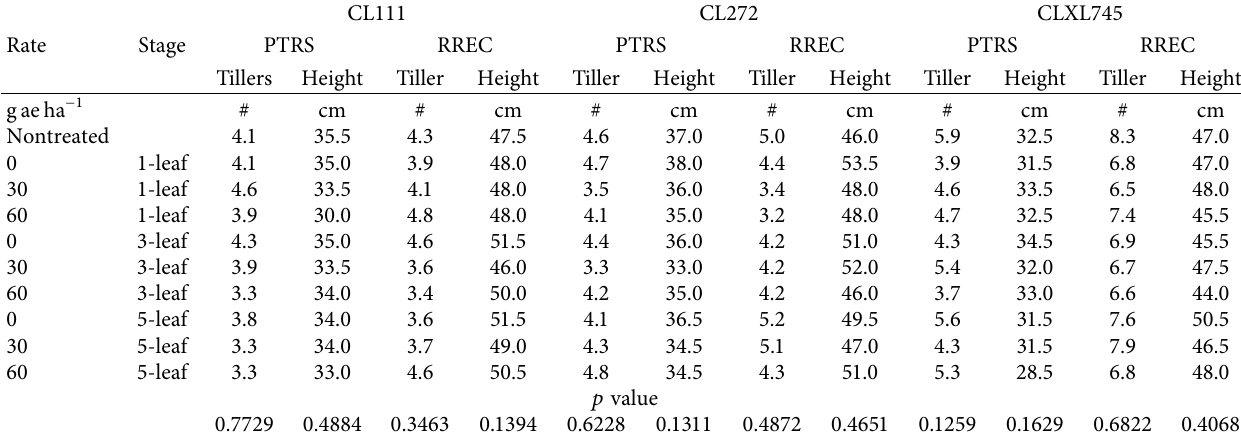
Table 2: Number of tillers and plant height for CL111, CL272, and CLXL745 to various rates of florpyrauxifen-benzyl and imazethapyr at different growth stages a,b,c